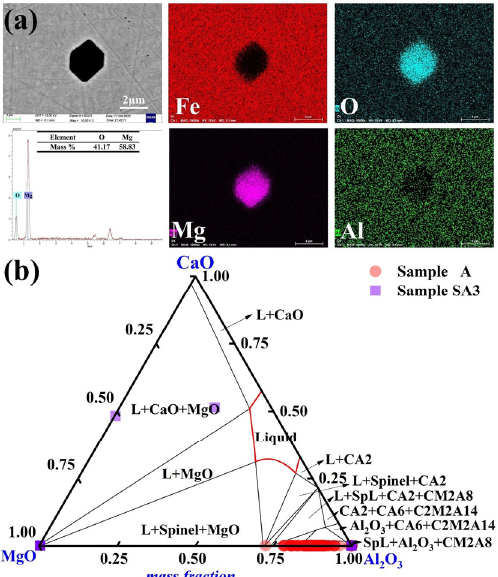
Figure 6. Morphology and makeup of the typical inclusions in Sample A3: ( a ) elemental distribution of the point inclusions and ( b ) composition distributions of the inclusions in Samples A and A3 in the MgO-Al 2 O 3 -CaO phase diagram. At 1600 °C, the solid lines depict the boundaries between several phases.